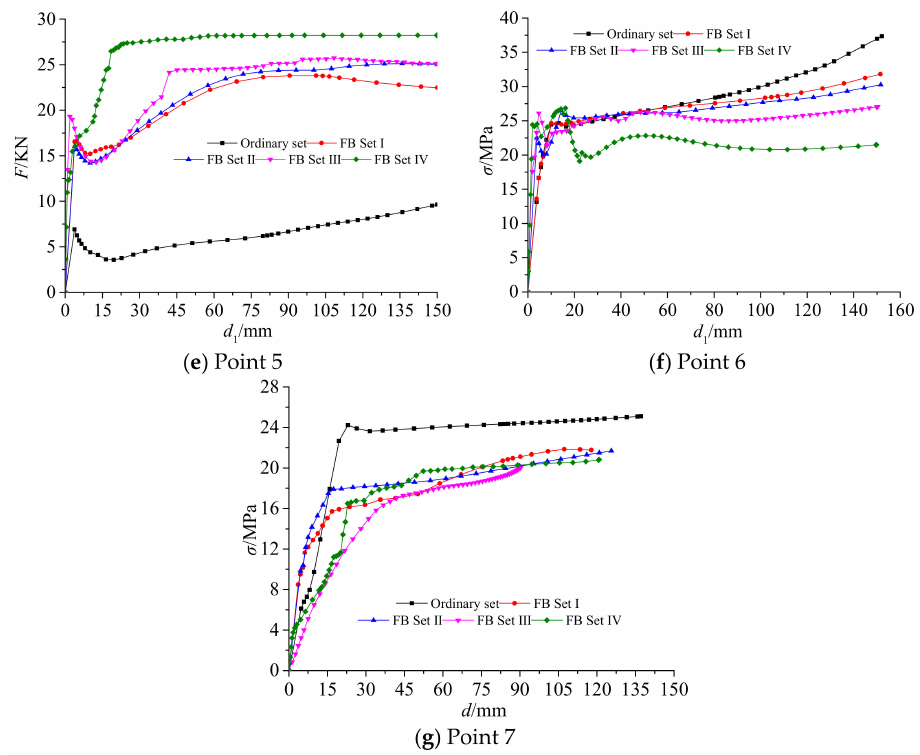
Figure 20. The stress-strain of the FB